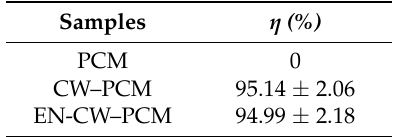
Figure 4. Leakage test of PCM, CW–PCM, and EN-CW–PCM at different temperatures. Table 2. Solar-to-thermal conversion